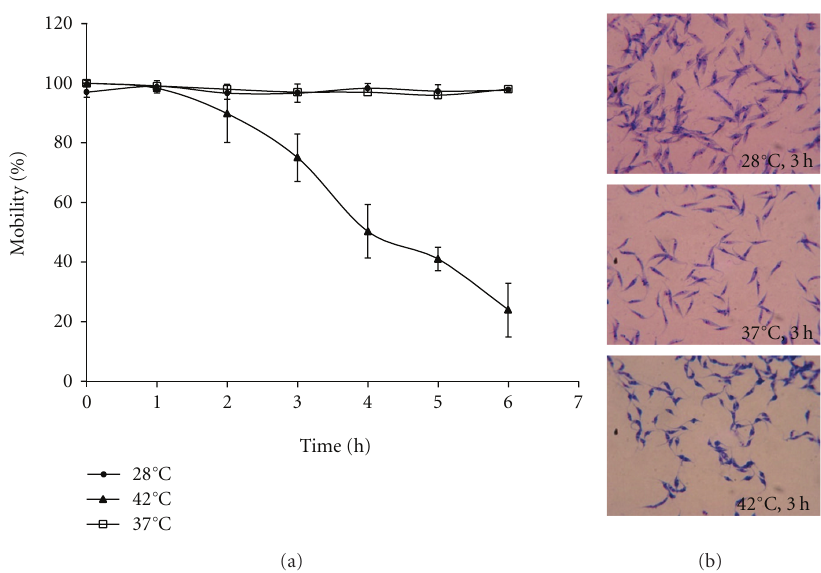
Figure 1: T. cruzi epimastigotes mobility and morphology after heat shock. (a) T. cruzi of the strain Ninoa in log phase growth were incubated at 28, 37, or 42 ◦ C for 1 to 6 h. Aliquots of each culture were taken each hour, and the number of mobile and immobile parasites was determined in a hemocytometer by observation in a microscope. The data are representative of three independent experiments and are shown as the mean ± SD. (b) Epimastigotes Giemsa-stained in log phase growth incubated at 28, 37, or 42 ◦ C for 3h are